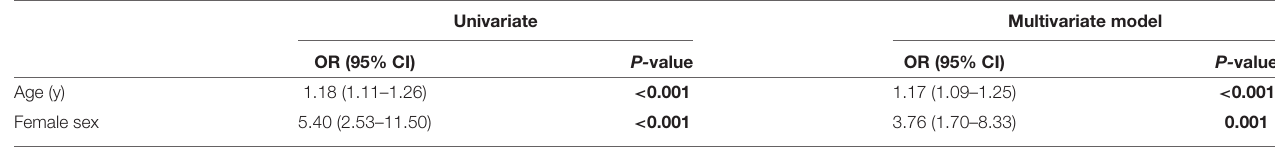
TABLE 4 | The logistic regression analysis to identify risk factors associated with LVA at the anterior wall of LA.